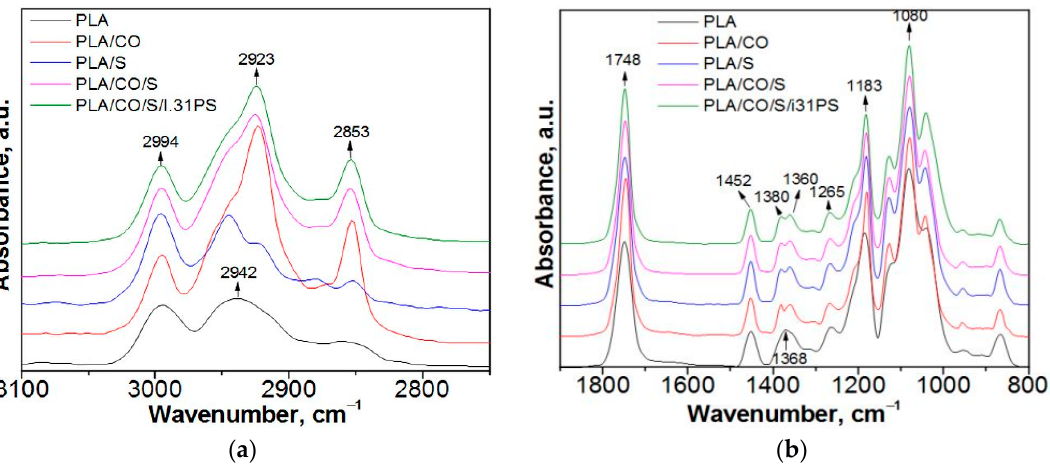
Figure 1. Normalized ATR-FTIR spectra for the PLA-based biocomposites in ( a ) the 3100–2700 cm − 1 region and ( b ) the 1900–800 cm − 1 region.